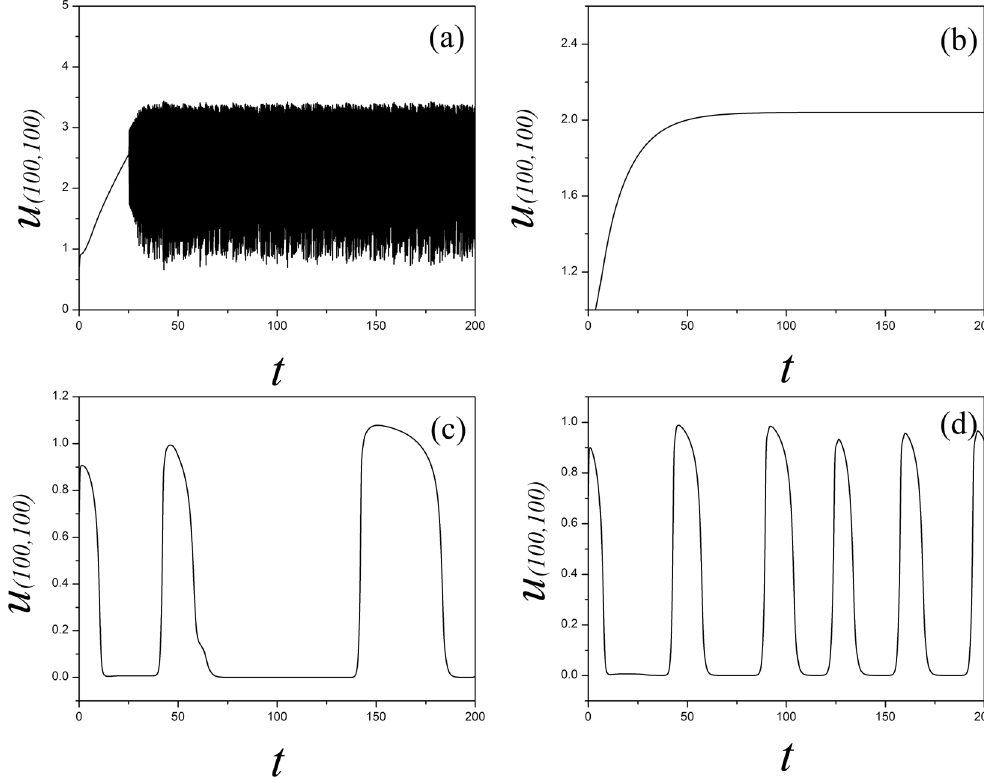
Figure 5. Sampled time series for membrane potential for the node (100, 100) are calculated with different gain k 2 being used, the parameters are set as k 0 = 0.1, k 1 = 0.5 , α = 1 , β = 2, for ( a ) k 2 = 0.1; ( b ) k 0 = 0.2; ( c ) k 2 = 0.5; ( d ) k 2 = 1.0.